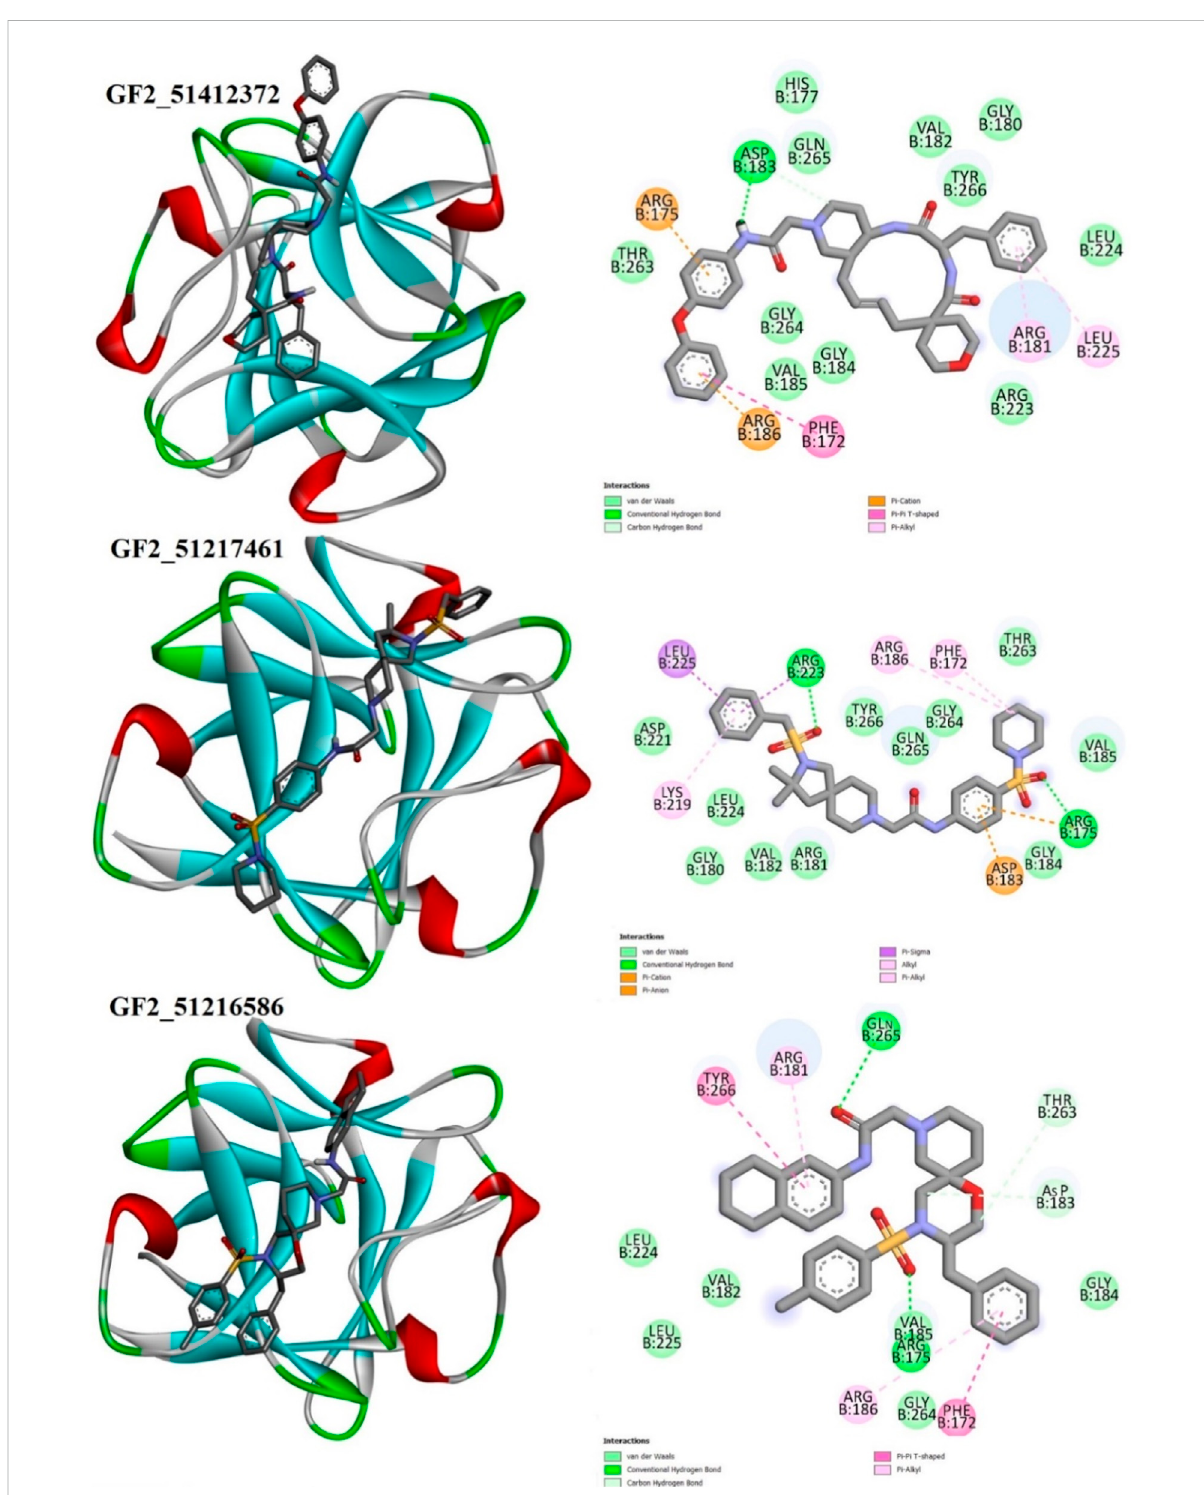
FIGURE 5 Bindingposeofthebestbindingmolecules(showningraysticks)toanFGF2receptor(shownin3Dcoloringwhereeachspeci fi ccolorspeci fi es a particular secondary structure element). Binding interactions of the compounds with the FGF2 are also